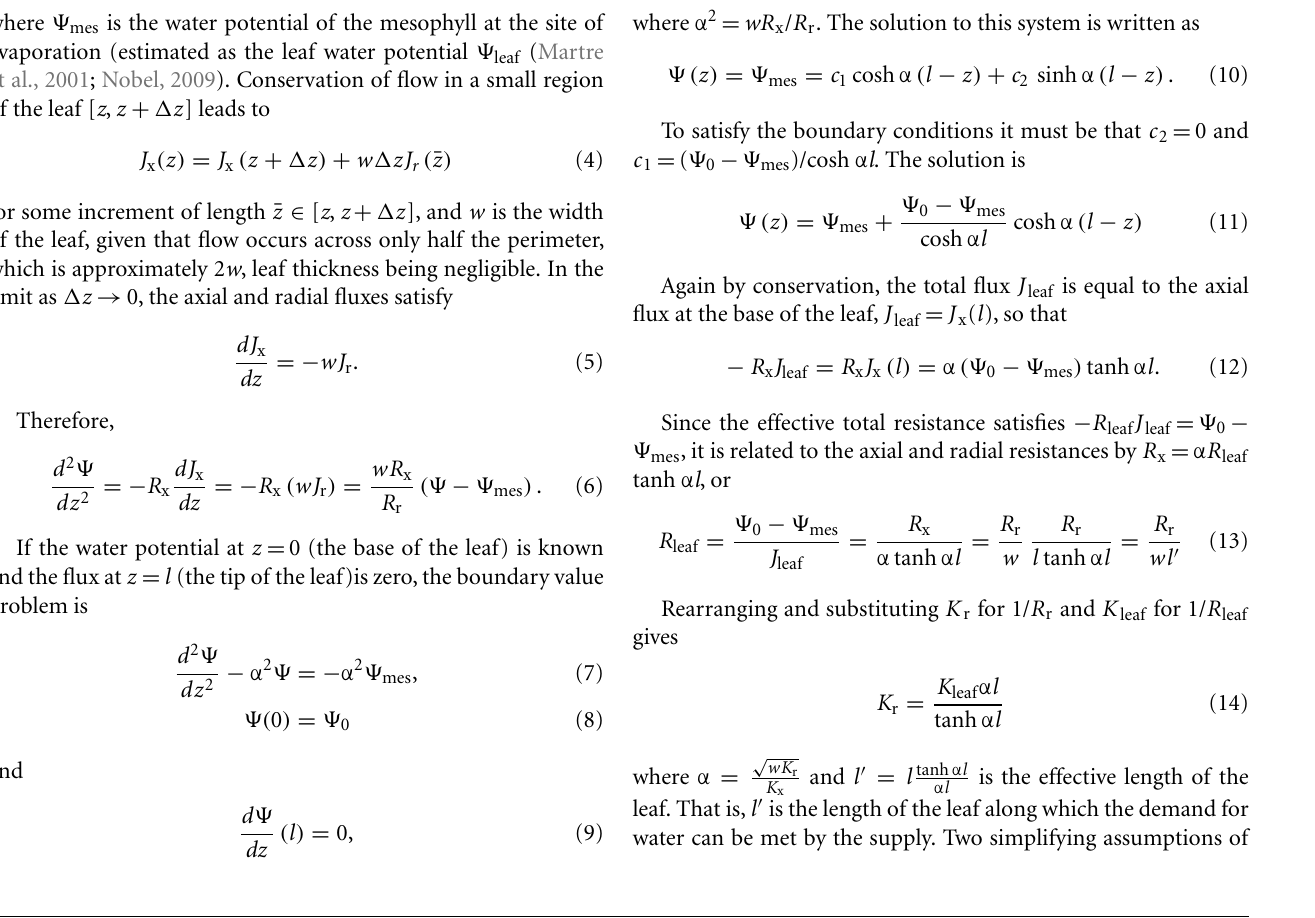
between vein and abaxial surface (red line in (C) used to calculate D mes; black arrow indicates distance between vein and epidermis D epi ); scale bars in (C) and (D) = 50 µ m. Abbreviations: bundle sheath cells (bs), hydrenchyma (hyd), mesophyll (mes), stomate (sto), and trichome